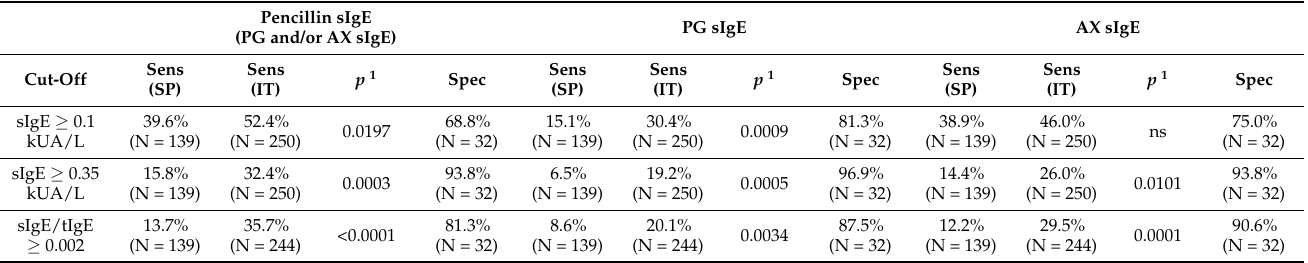
Table 3. Sensitivity and specificity values for the detection of specific IgE to penicillin G and amoxi- cillin by ImmunoCAP ® comparing different